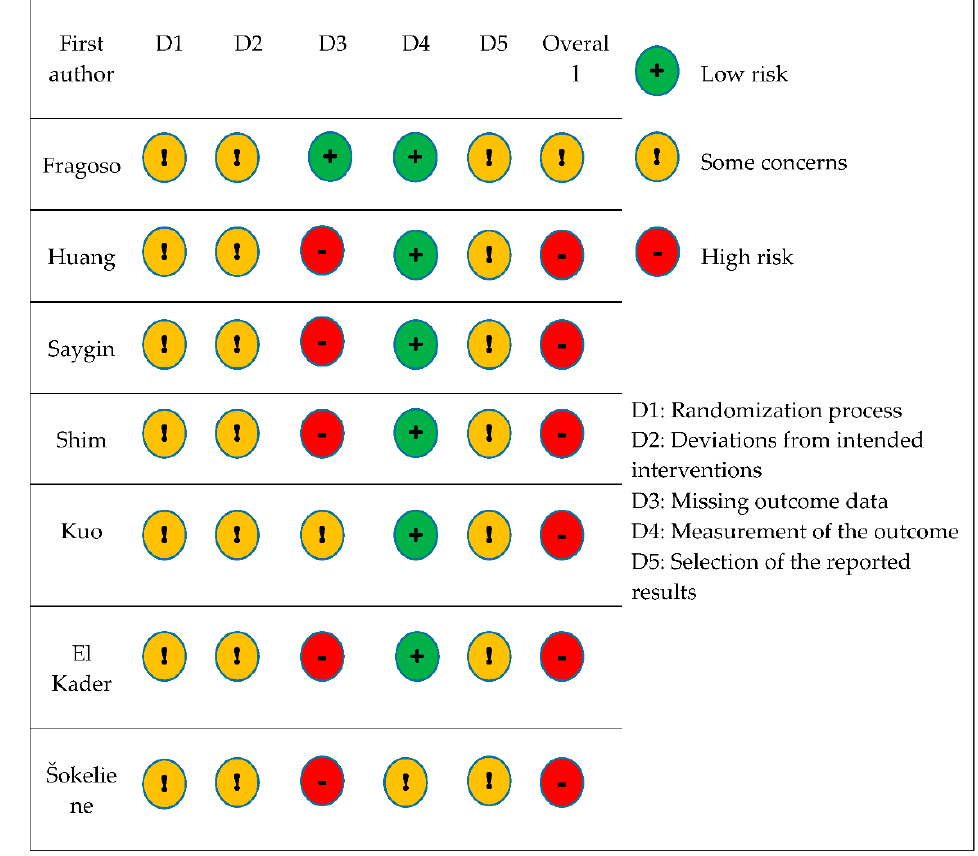
Figure 2. Risk of bias summary of the included studies.